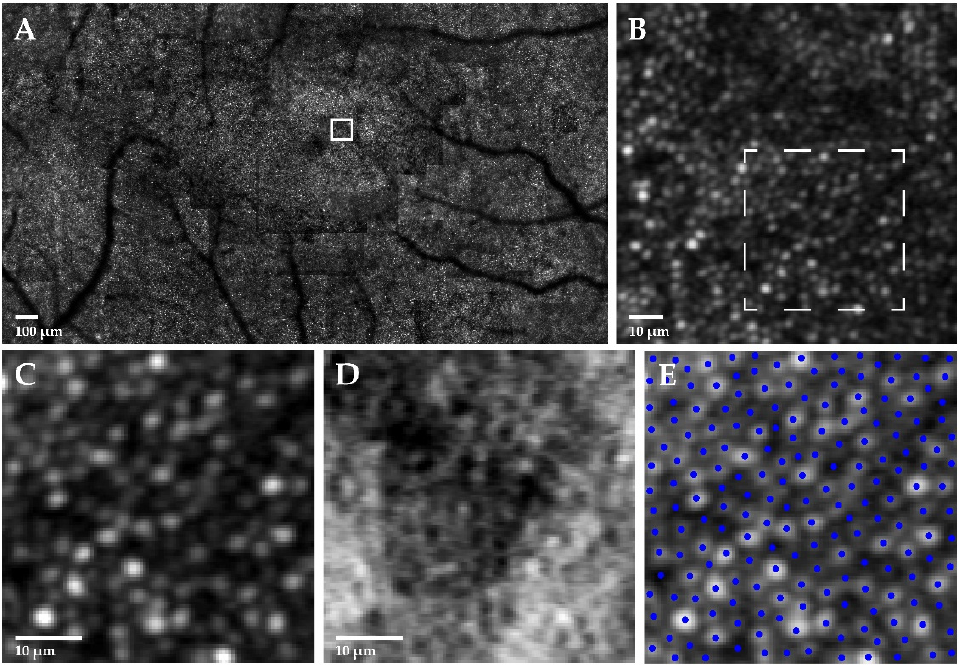
Figure 6. Adaptive optics scanning laser ophthalmoscopy (AOSLO) cone density analysis. AOSLO imaging of the right eye in a 33-year-old female with USH2A -associated non-syndromic retinitis pigmentosa is shown. ( A ) 1.5° field of view confocal photoreceptor mosaic with a 100 × 100 μ m cone sampling window (solid white square) applied at 100 μ m eccentricity to generate ( B ) a region of interest (ROI). A magnified section of the ROI (dashed white square) is displayed in ( C ) confocal and ( D ) split-detection modalities, with ( E ) manual cone identification (blue circles) performed in the